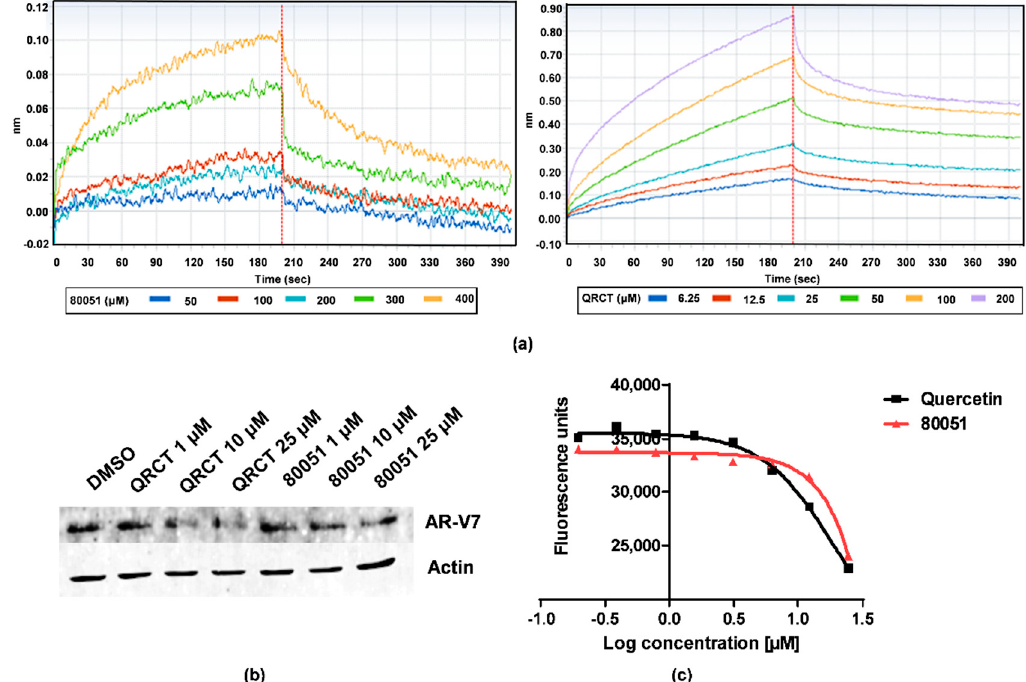
Figure 3. In vitro characterization of VPC-80051 hnRNP A1 inhibitor. ( a ) Dose-dependent direct binding of VPC-80051 and control quercetin (QRCT) to purified UP1 domain of hnRNP A1 protein quantified by bio-layer interferometry (BLI). ( b ) Reduction of levels of AR-V7 splice variant upon treatment with 10 and 25 µ M of VPC-80051 and QRCT as analyzed by Western blotting. ( c ) Reduction of 22Rv1 cell viability upon treatment with VPC-80051 and quercetin at greater than 10 µ M doses where decrease in AR-V7 levels was observed.